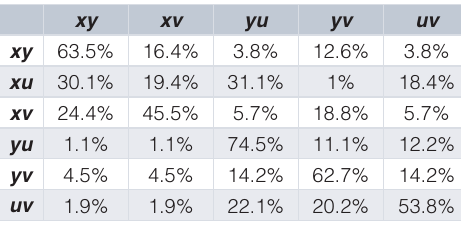
Table 3. Proportion contribution matrix P for the network of topical antibiotics without steroids for chronically discharging ears. Cells show the proportion contribution of direct comparisons indicated in the column to the network meta-analysis treatment effects indicated in the rows.